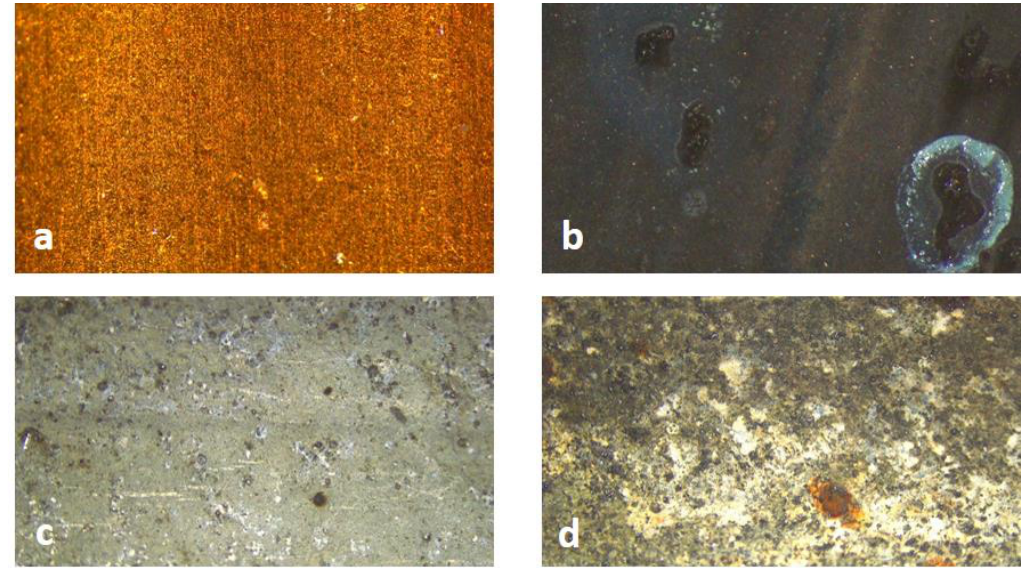
Figure 2. Cu pipe—new ( a ), Cu pipe—8 weeks ( b ), galvanized steel—new ( c ), and galvanized steel—8 weeks ( d ).